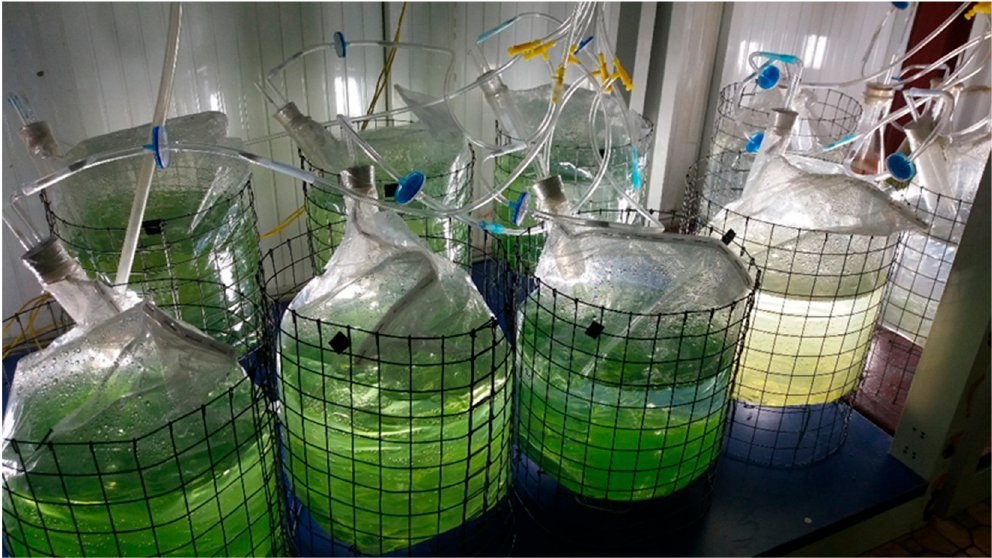
Figure 3. Suspended cultivation of H. pluvialis in 10 L PE bags.